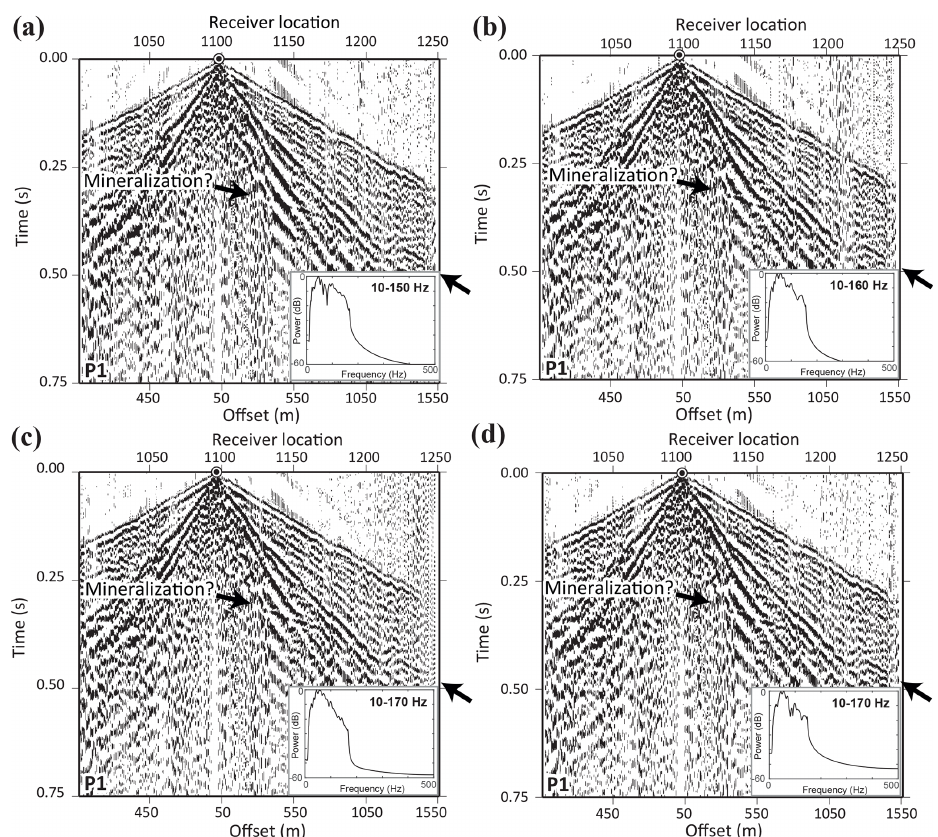
Figure 6. Shot gathers (after cross-correlation) and their corresponding amplitude spectra along the cabled part of P1 showing sweep pa- rameter tests with the following parameters: (a) 10–150Hz, 60% force, and 17s sweep length; (b) 10–160Hz, 60% force, and 17s sweep length; (c) 10–170Hz, 60% force, and 20s sweep length; and (d) 10–170Hz, 70% force, and 20s sweep length. Both higher end frequencies of 160 and 170Hz were judged to be suitable; however, we decided to choose 160Hz because it produced less ground-roll energy compared to 170Hz. The arrow shows the expected reflection from the